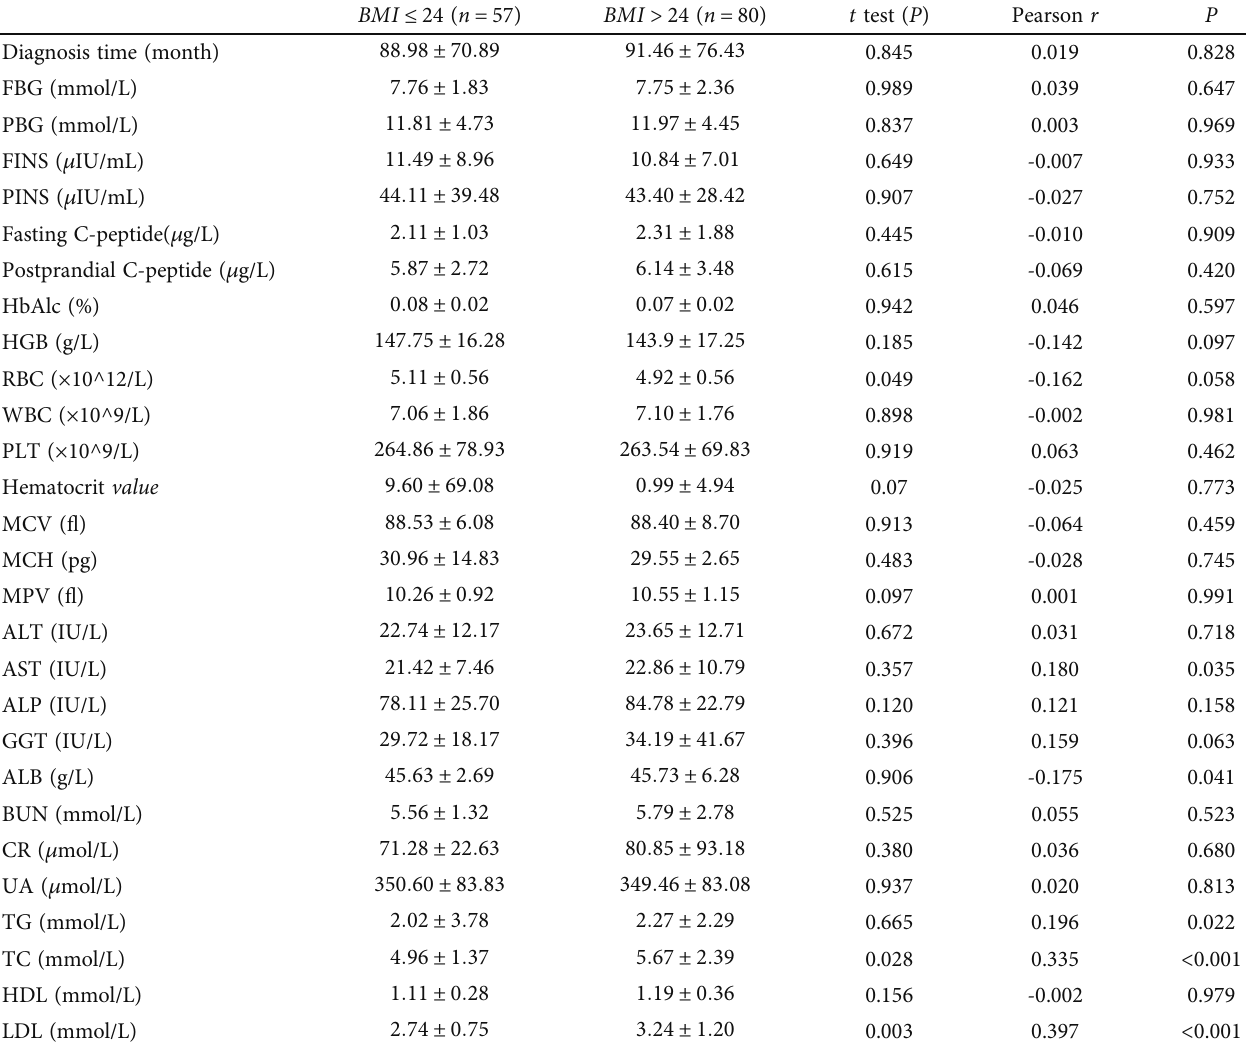
Table 2: The di ff erences and correlation of clinical characteristics and miR-210 level between BMI ≤ 24 and BMI > 24 groups in patients with type 2 diabetes